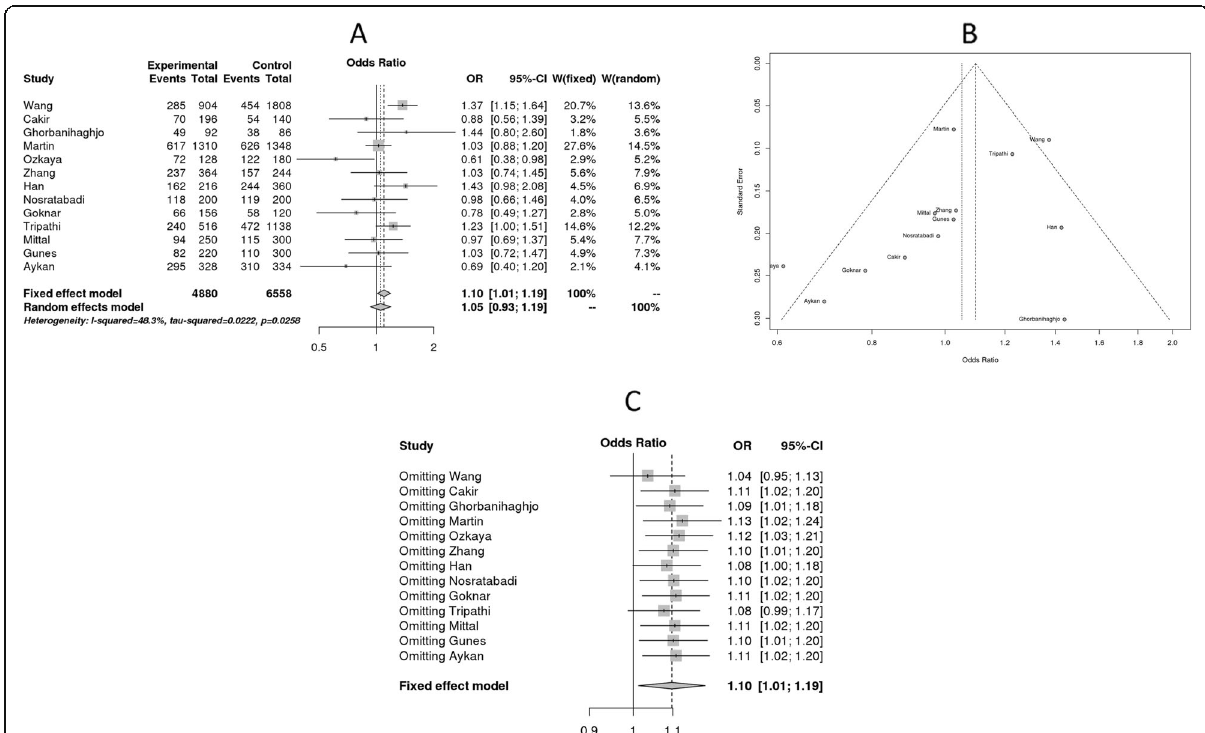
Fig. 3 Meta-analysis of association studies on VDR ApaI polymorphism vs. risk for renal disease. Forest plot: The terms experimental and control groups correspond to cases and controls. Number of variant alleles were considered as events with respect to total number of alleles tested. This meta-analysis was based on 13 case-control studies representing 5 population groups. VDR ApaI polymorphism was shown to exert risk for renal disease only in fixed effect model, but not in random effect model. Funnel Diagram: It is depicting that two studies are contributing to heterogeneity. Sensitivity analysis: Excluding two studies is influencing the